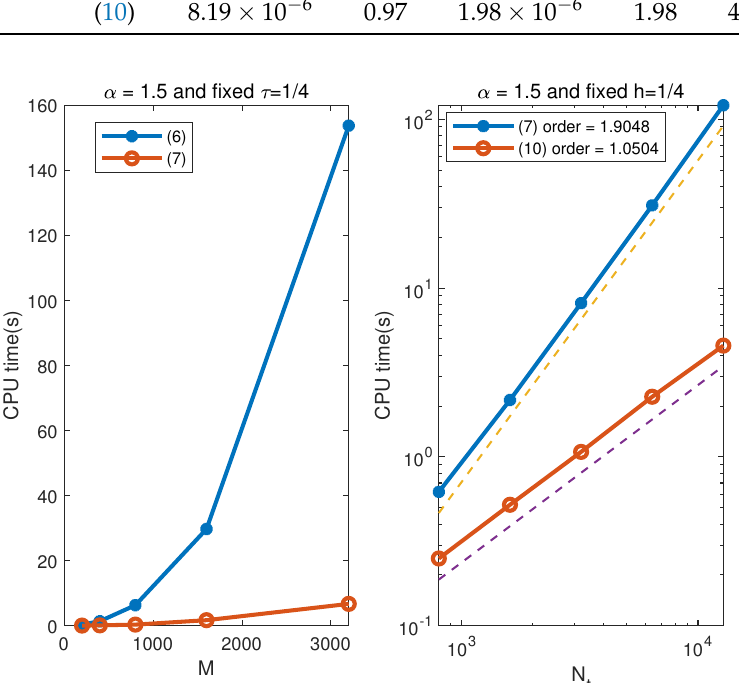
Figure 1. Comparison of computational costs with fixed α = 1.5. (The dashed lines below the numerical curves are the corresponding fitted curves, which are shifted down here for the convenience of